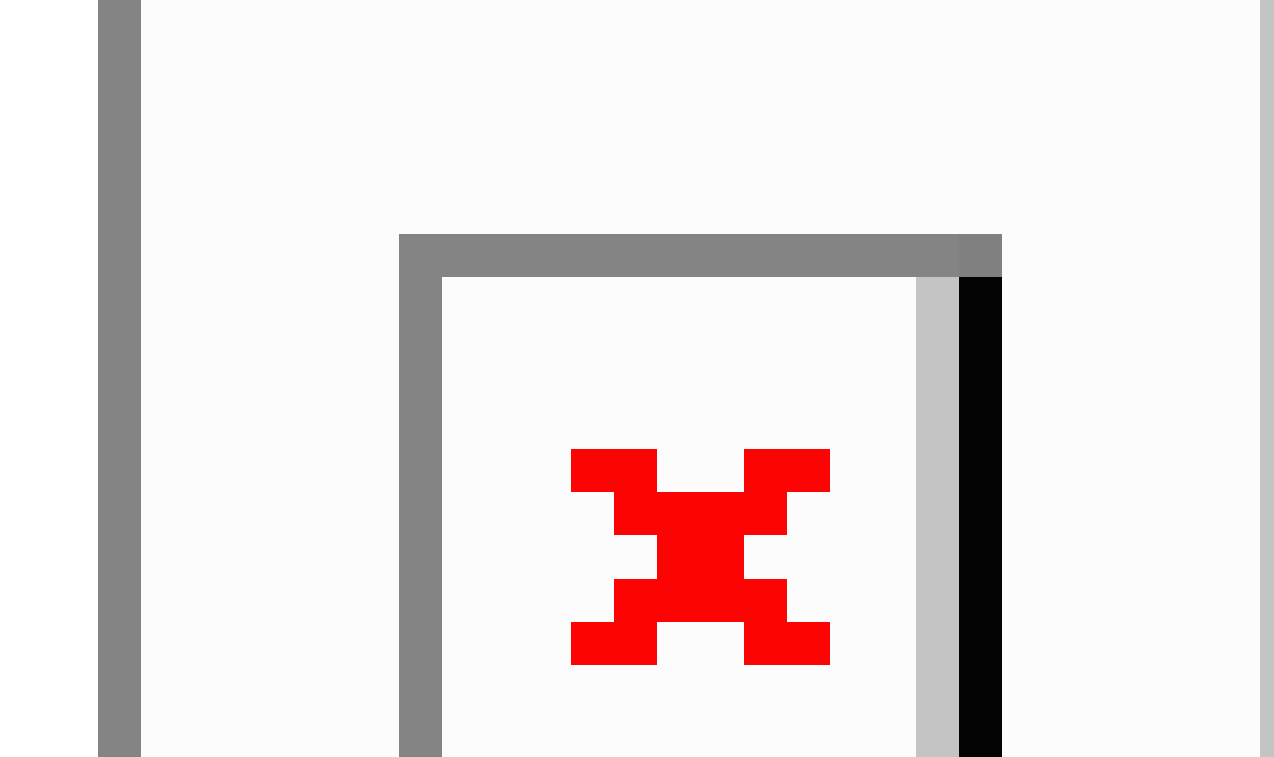
Figure 1. Screenshot of the